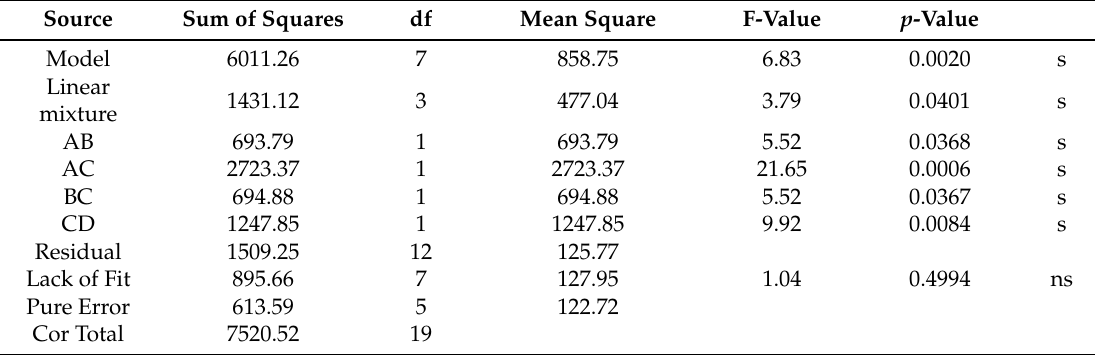
Table 3. Analysis of variance table for particle size (Poly- L -lactide-based